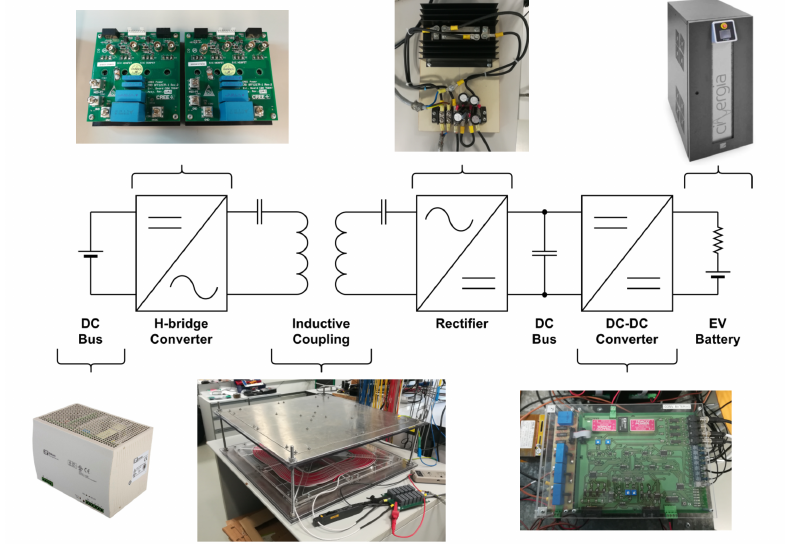
Figure 17. Scheme of the laboratory